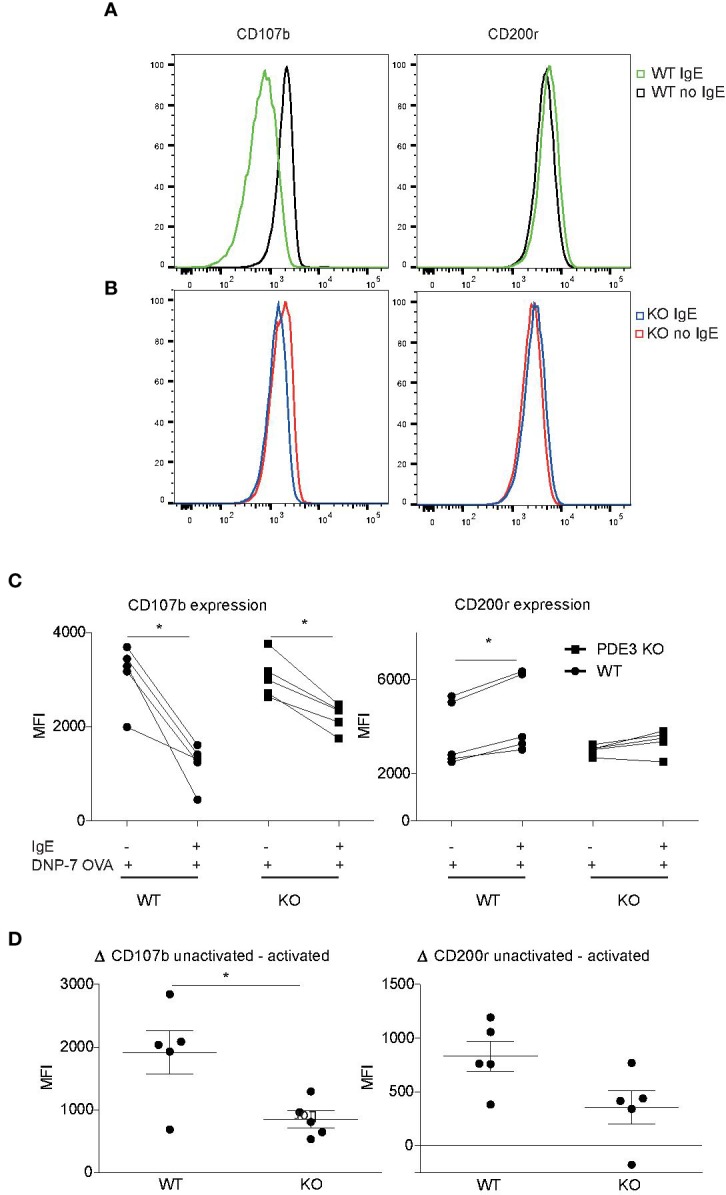
Mast cell activation is impaired when PDE3 is targeted. (A, B) Bone marrow-derived mast cells (MCs) obtained form Pde3−/− mice and wild-type (WT) control mice were sensitized with DNP-specific immunoglobulin E (IgE) or phosphate buffered saline (PBS), followed by stimulation with DNP-7 OVA. The mast cell activation markers CD107b and CD200r were evaluated and data are shown as histogram overlays. (C) Dot plots with median fluorescence intensity (MFI) values indicating reduction in CD107b and induction of CD200r upon DNP-7 OVA stimulation for WT and Pde3−/− mast cells. (D) ΔMFI for the indicated markers in MCs from WT and Pde3−/− mice (KO). A Wilcox signed test and a Mann-Whitney U test was used for statistical evaluation. *P < 0.05. Plots represent (n=5) of one of two independent experiments. MFI, median fluorescence intensity.